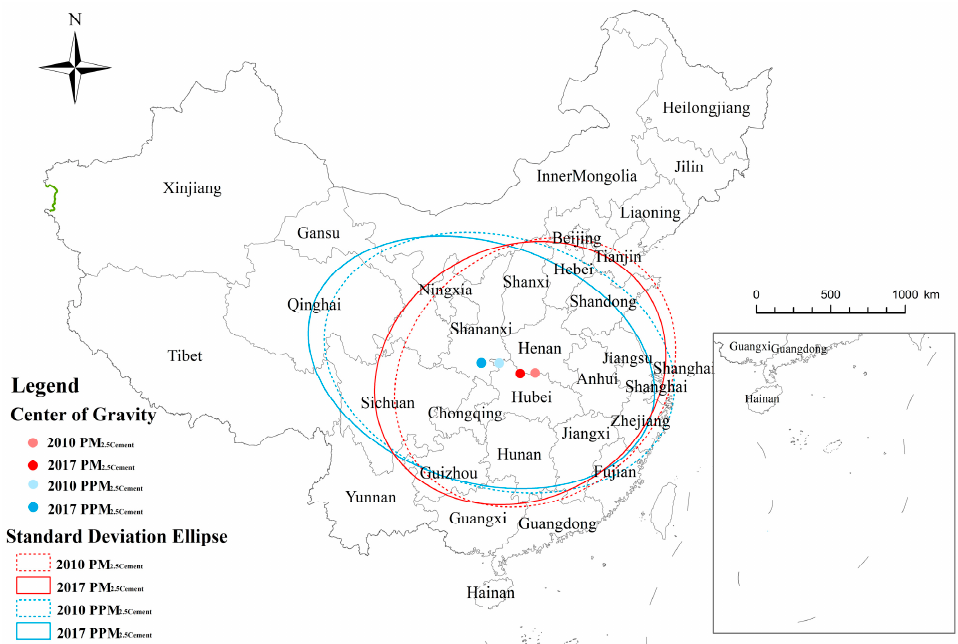
Figure 3. The standard deviation ellipse and gravity center migration for PM 2.5Cement and PPM 2.5Cement during 2010 and 2017.